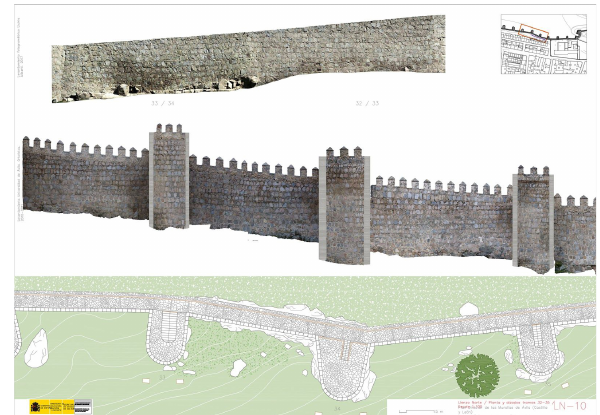
Figure 7. Example of one of the plans: floor plan, orthophoto of ​ the exterior side (University of Avila) and orthophoto of the interior